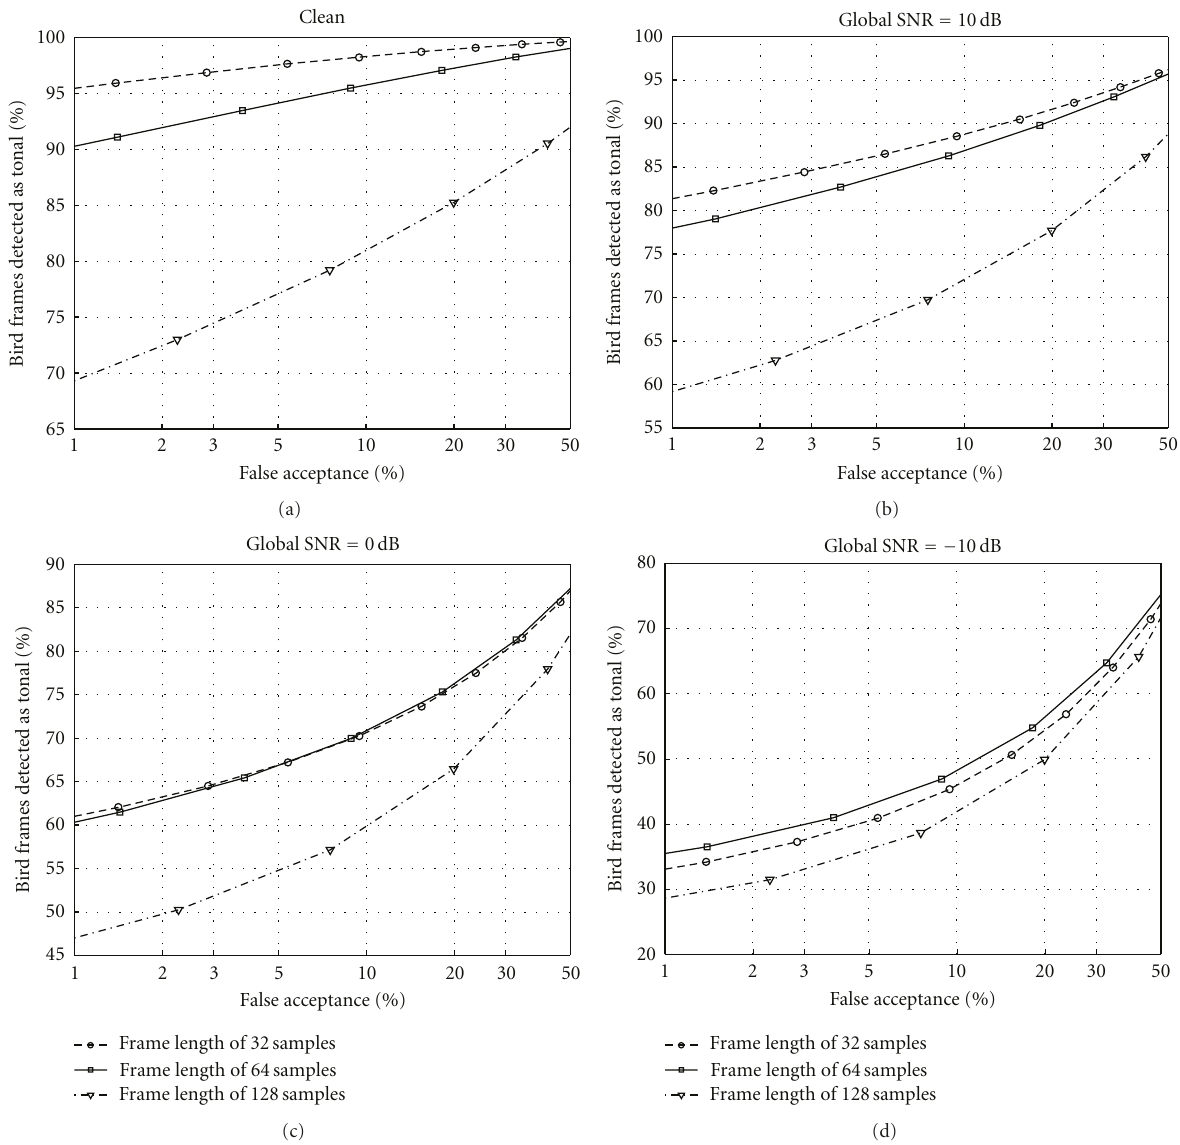
Figure 2: Percentage of frames detected as tonal on bird data ( y -axis) versus on White noise ( x -axis; referred to as false-acceptance). Bird data: clean (a) and corrupted by White noise at various global SNRs (b)–(d). Frame length [samples]: 32 (circle dashed line), 64 (square full line), and 128 (triangle dash-dotted